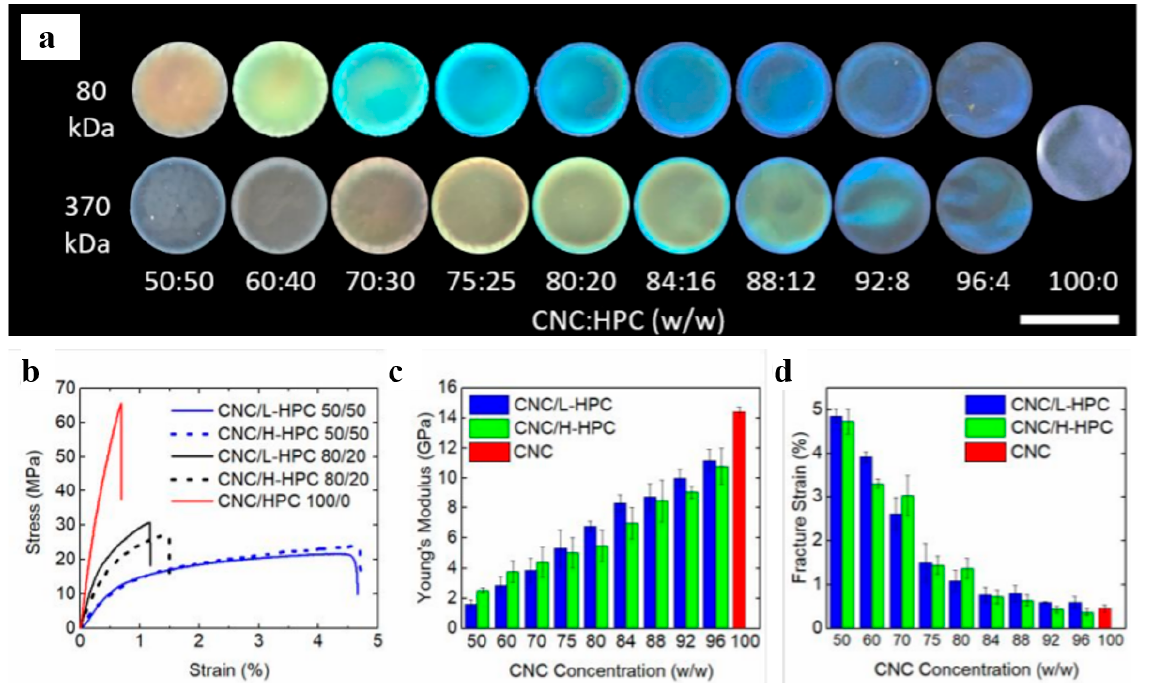
Figure 17. ( a ) Photographs of iridescent films prepared with varying molecular weight and HPC concentration (scale bar, 3.5 cm); ( b ) stress–strain curves for different CNC/HPC composite films; ( c ) Young’s modulus for different CNC concentrations for both H-HPC (370 kDa) and L-HPC (80 kDa) composite films; ( d ) fracture strains for different CNC concentrations for both H-HPC and L-HPC composite films. Reproduced from [112].